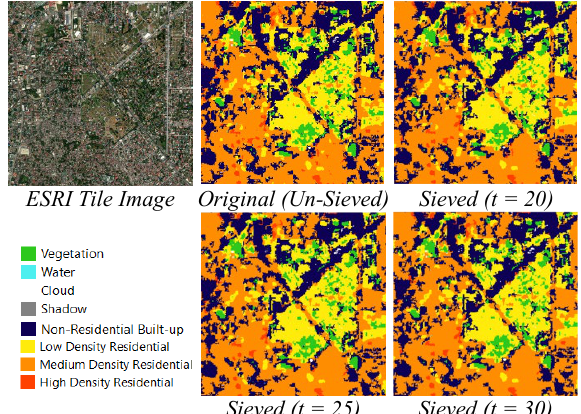
Figure 14. Original and sieved outputs (Level 3 best output) Sieving was once again performed, as shown in Figure 14. Same with Level 2, the overall accuracies improve as the threshold increases. Moreover, the linear and polynomial models were enhanced as the sieve threshold increased. Small refinement was seen in the RBF models. Overall, while there is an improvement, these were very minimal.